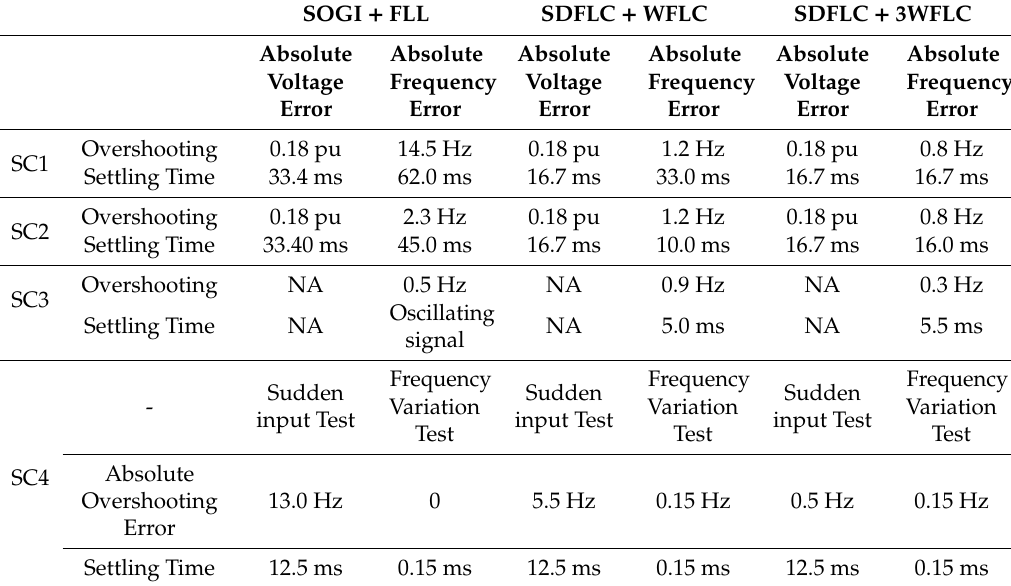
Table 5. Simulation